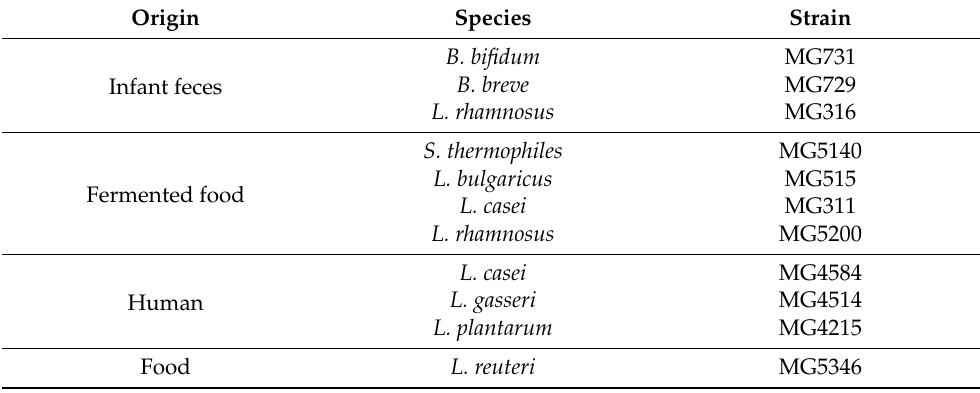
Table 1. The origins and species of the 11 bacterial